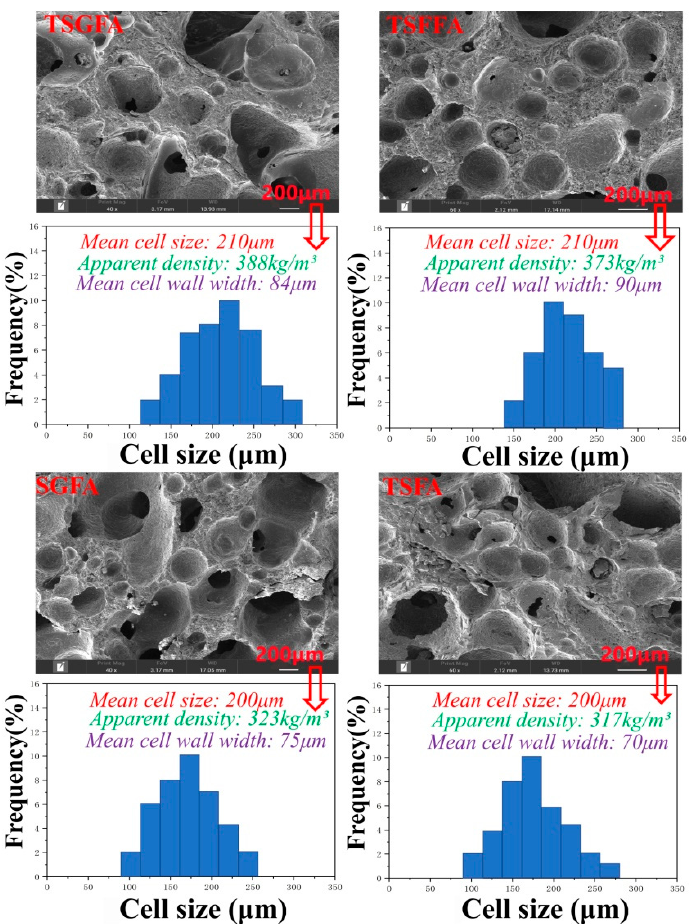
Figure 2. SEM micrographs, apparent density, and cell size distribution of the different starch-based foams.